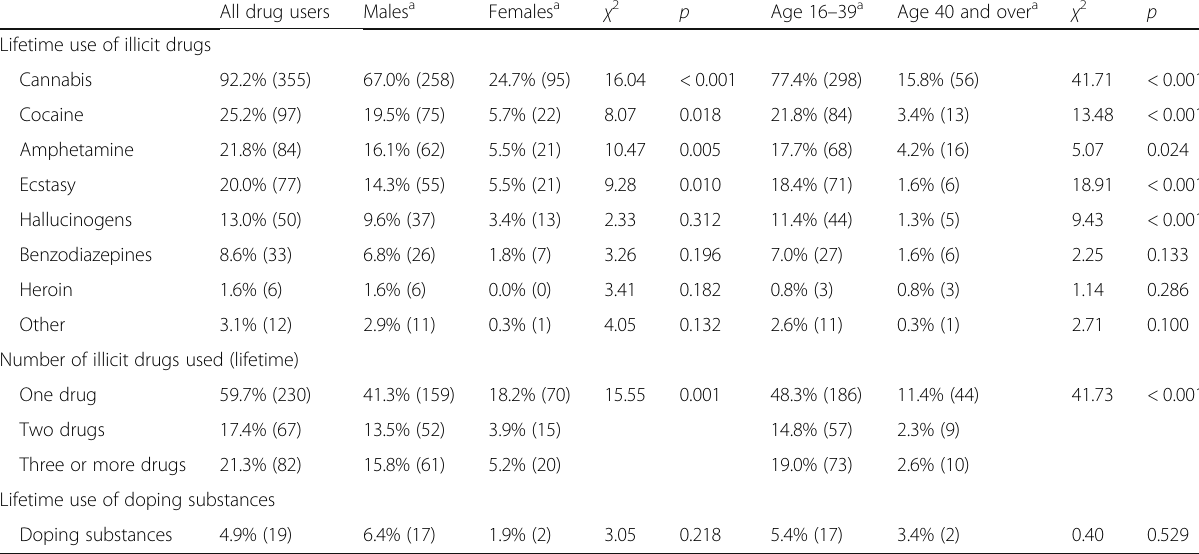
Table 3 Drug characteristics among gym-goers who reported lifetime drug use ( n = 385)